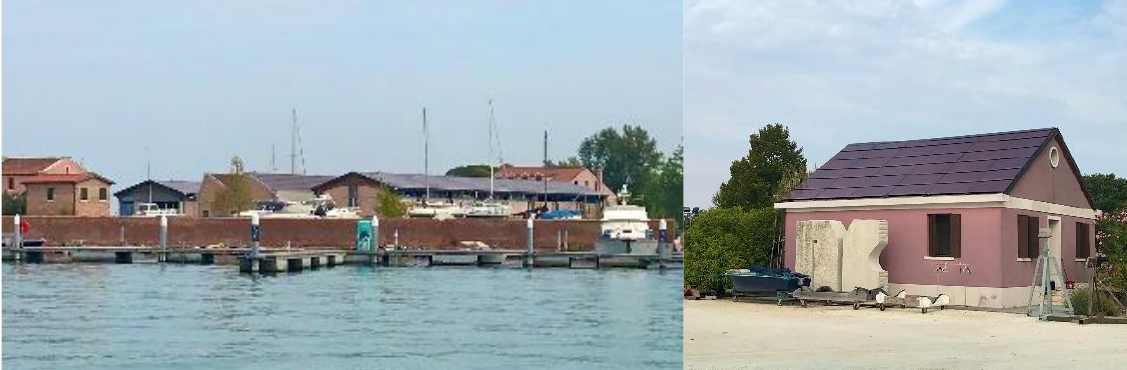
Figure 6. Positive example of the “ minimum intervention ” criteria on the PV roof of the La Certosa Island in Venice (Italy) with respect to the geometries, shapes, proportions, colors, and reflectance of traditional clay roofs [74] (Source: Elena Lucchi).